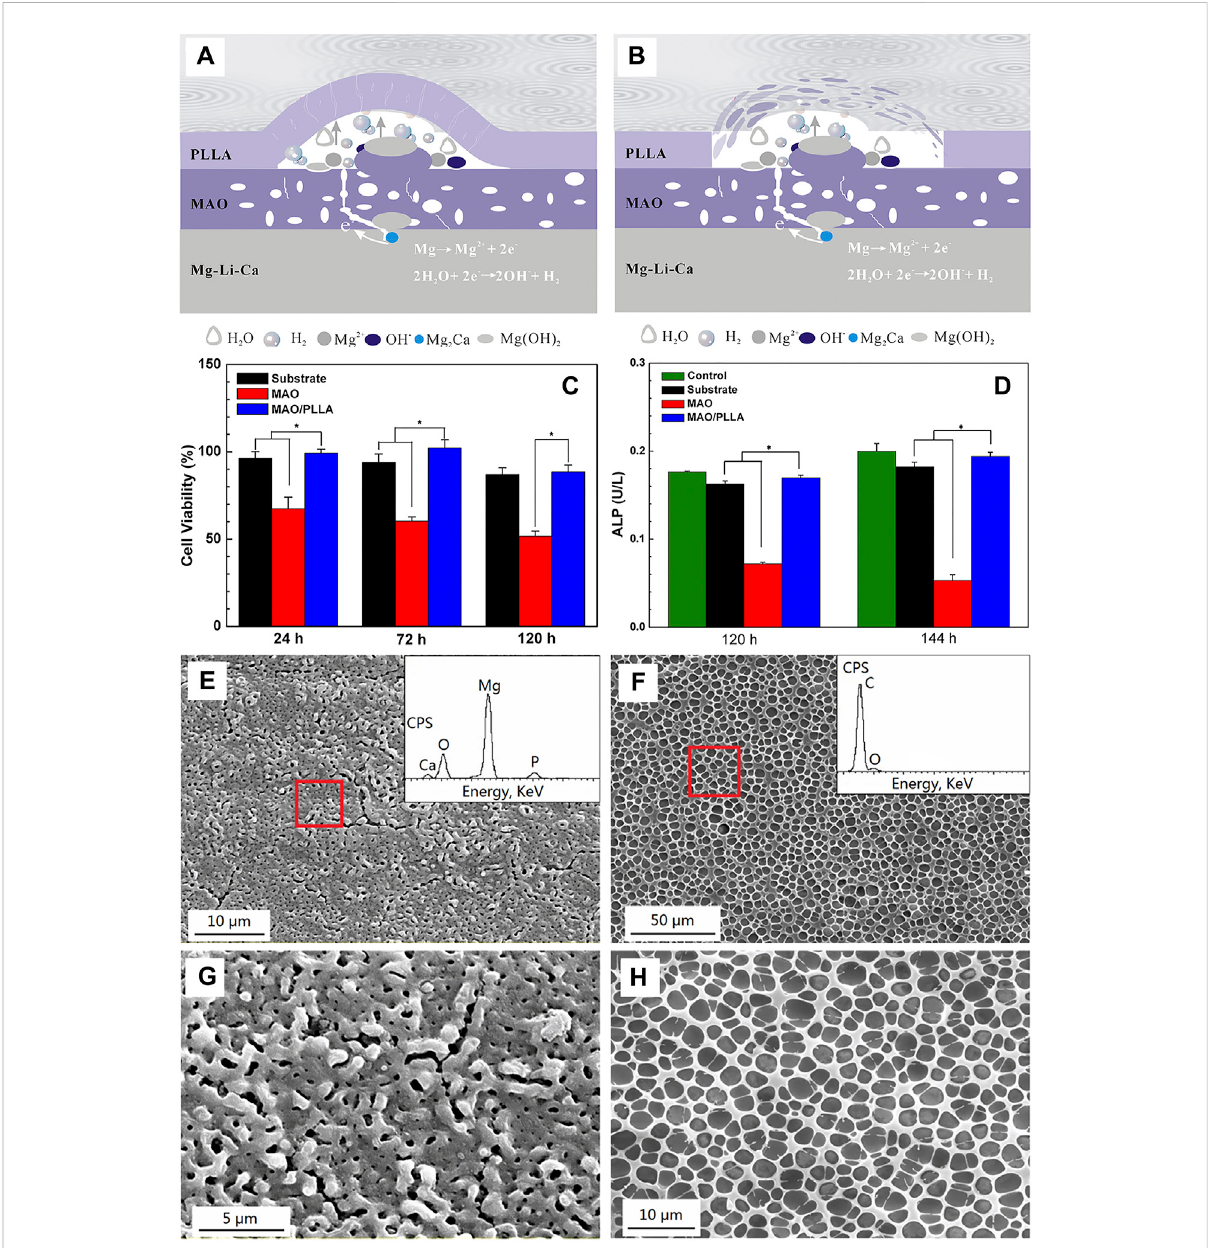
FIGURE 5 Schematic diagrams of the degradation mechanism of porous MAO/PLLA composite coatings on Mg-1Li-1Ca alloys: (A) swelling of PLLA and corrosionofthesubstrate,and (B) blisteringand fi nalpeeling-offofPLLA; (C) RGRand (D) proliferationanddifferentiationofMC3T3-E1cellscultured for differenttimes indifferentextracts. Error bars represent ± S for n = 5and 3, respectively, and p < 0.05, as indicated by theasterisk (*); SEM images of (E) the MAO coatings; (F) the MAO/PLLA composite coatings, (G,H) the high magni fi cation view of e and f, respectively. Reprinted with permission from reference (Zeng et al., 2016), American Chemical